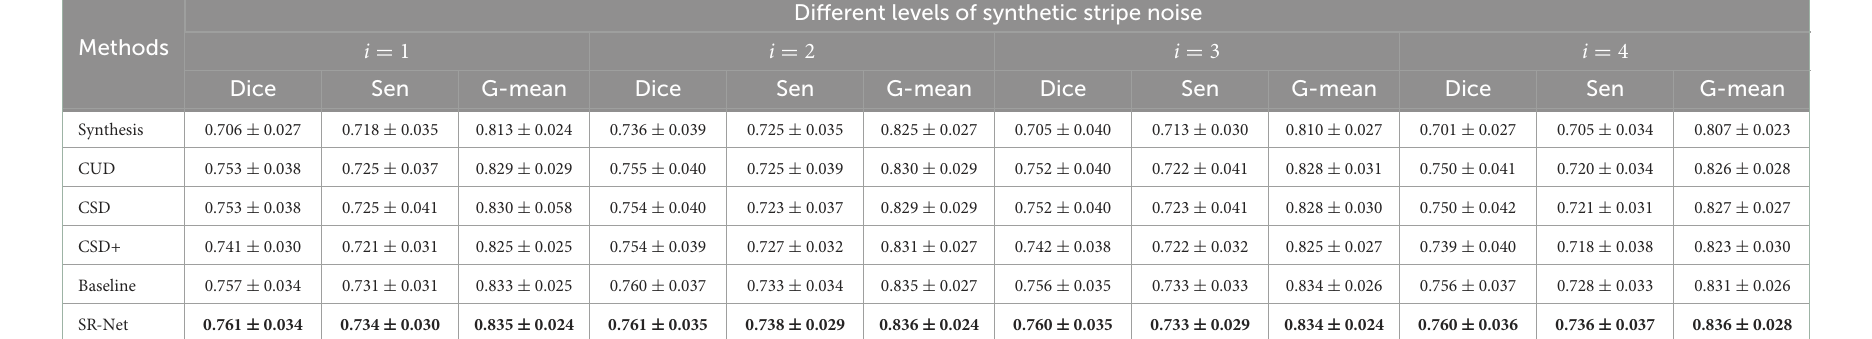
TABLE 2 Vessel Segmentation on de-striped images in ROSE dataset, in the presence of different levels of synthetic stripe noise.